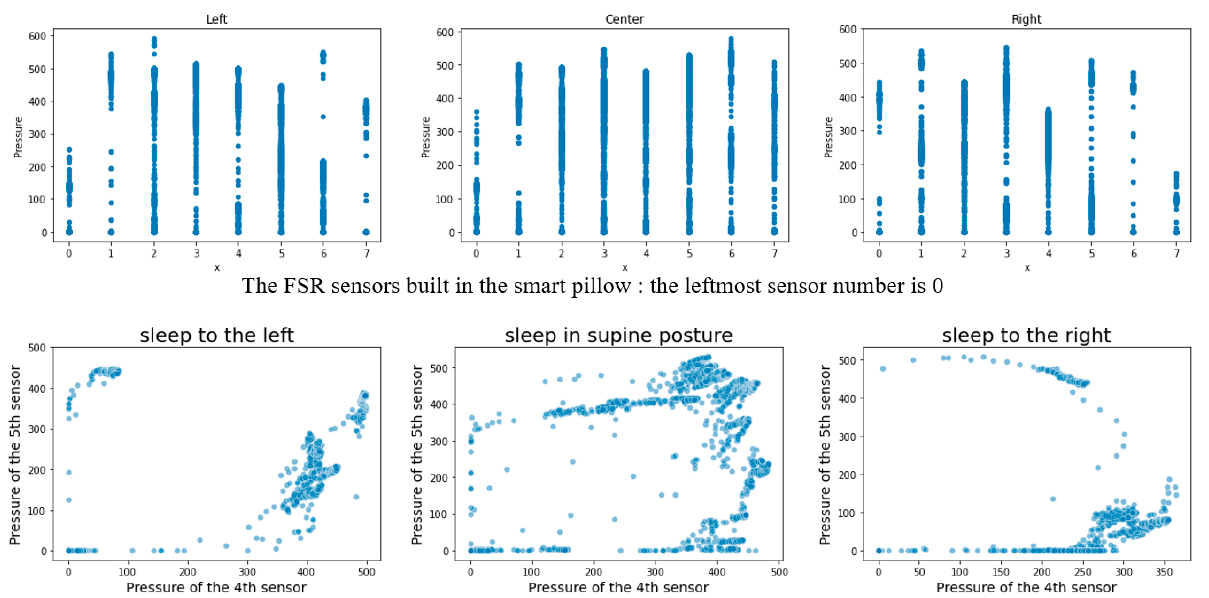
Figure 10. Average pressure intensities of the FSR sensors with respect to the sleeping posture.